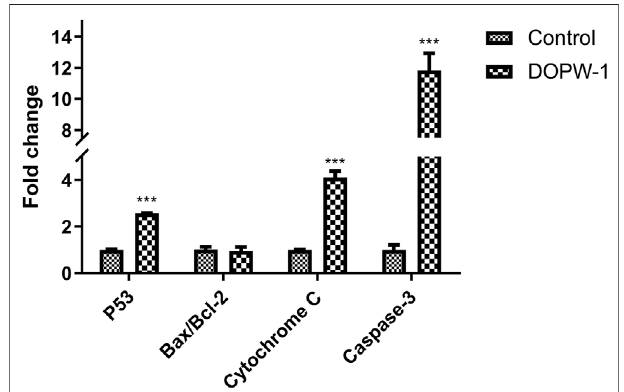
FIGURE 9 | Effect of different treatments on gene expression. *** P < 0.001 for the DOPW-1 group vs . the control group.